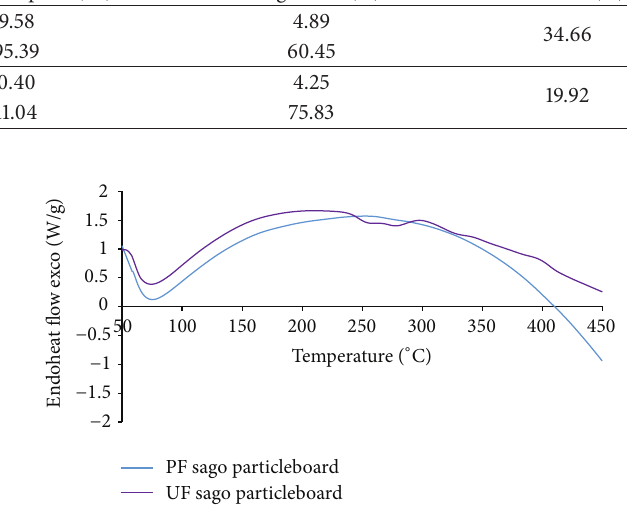
Figure 11: Sago particleboard with different matrix analysis by